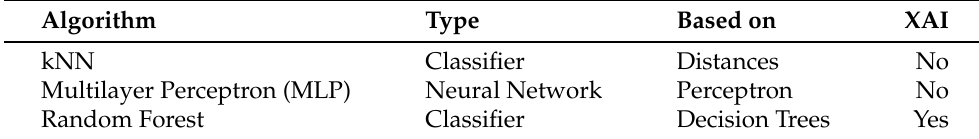
Table 5. Classification of comparative